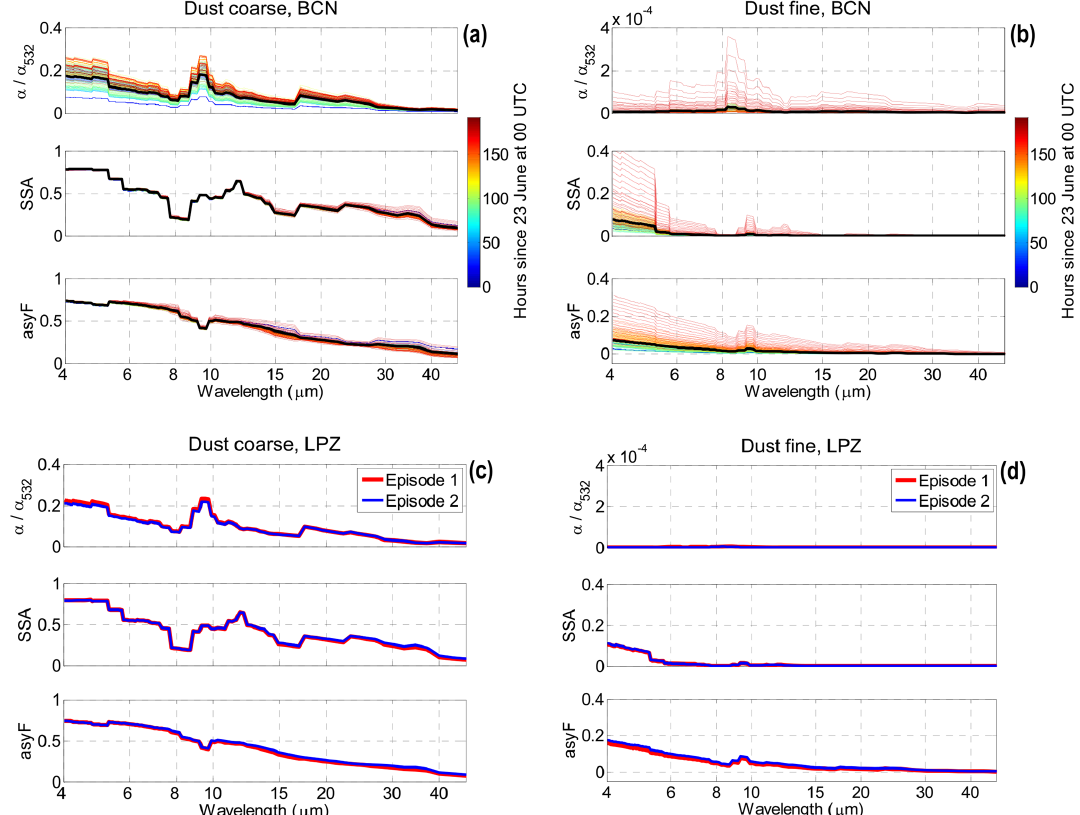
Figure 3. Spectral normalized extinction, α/α 532 , SSA and asyF in BCN for (a) Dc and (b) Df and in LPZ for (c) Dc and (d) Df. In BCN all hourly calculations are represented: 192 (8d). In LPZ the average of 29J-pm (Episode 1) and 30J-pm (Episode 2) is represented. In the BCN plots the thick black line represents the mean over the whole period (23–30 June).